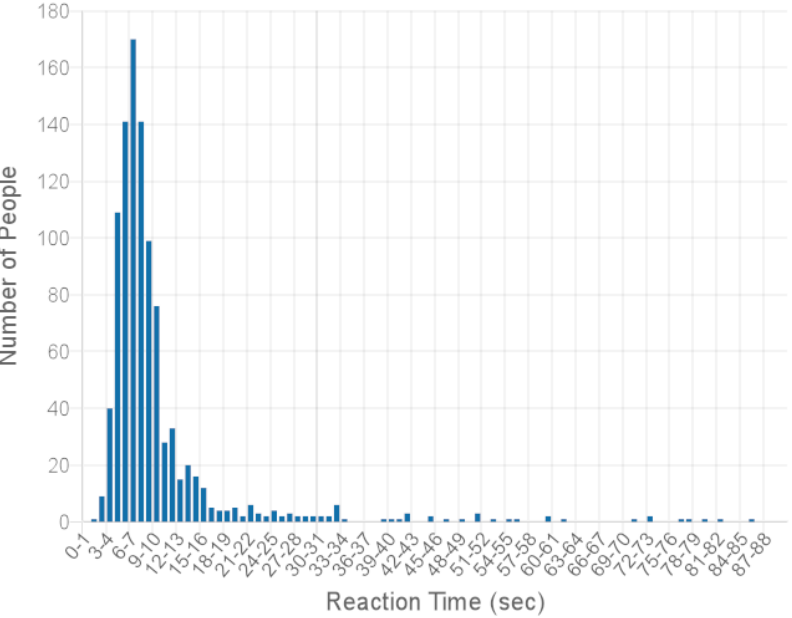
Figure A3. Reaction time distribution for Modern PC category, question PQ106-01. Missing values in the histogram: 6.